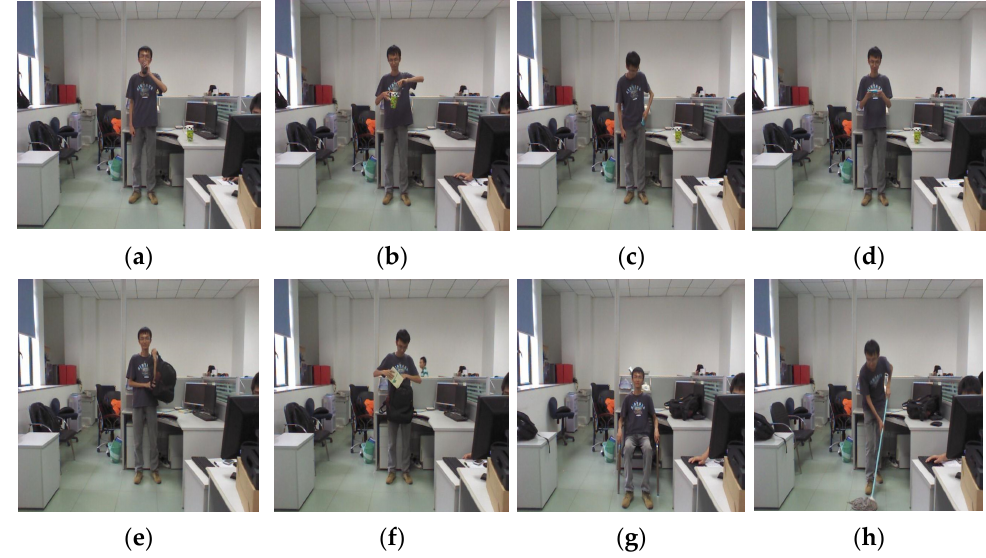
Figure 14. A few samples of the SYSU 3D HOI dataset, including ( a ) drinking, ( b ) pouring, ( c ) taking out wallet, ( d ) playing on phone, ( e ) wearing backpack, ( f ) packing backpack, ( g ) sitting in chair, and ( h ) mopping.